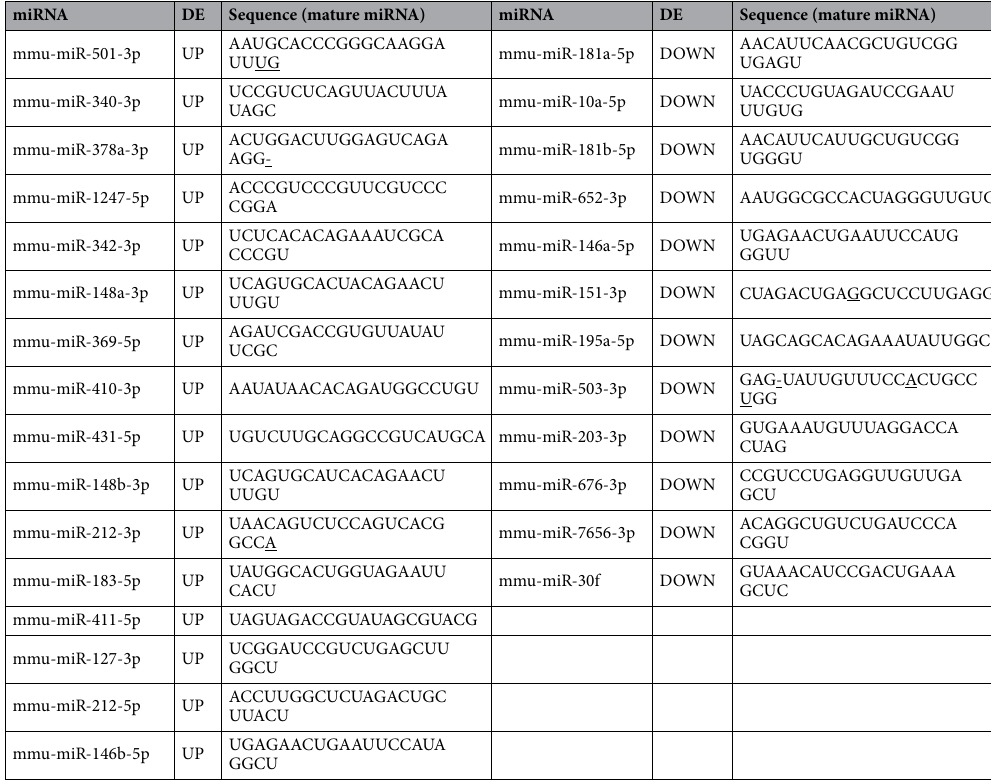
Table 1. Hit list of lung-function associated